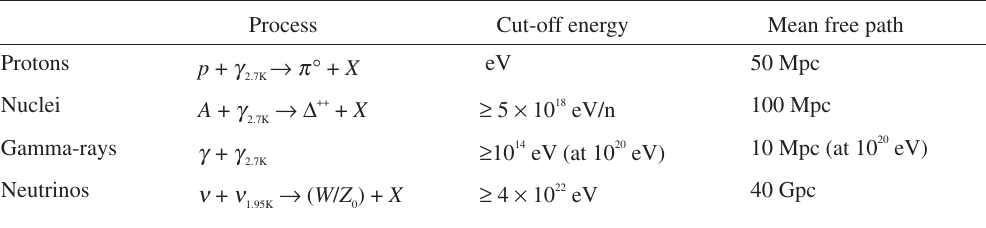
Table I. Extreme energy processes that cut-off the energy spectrum of particles in